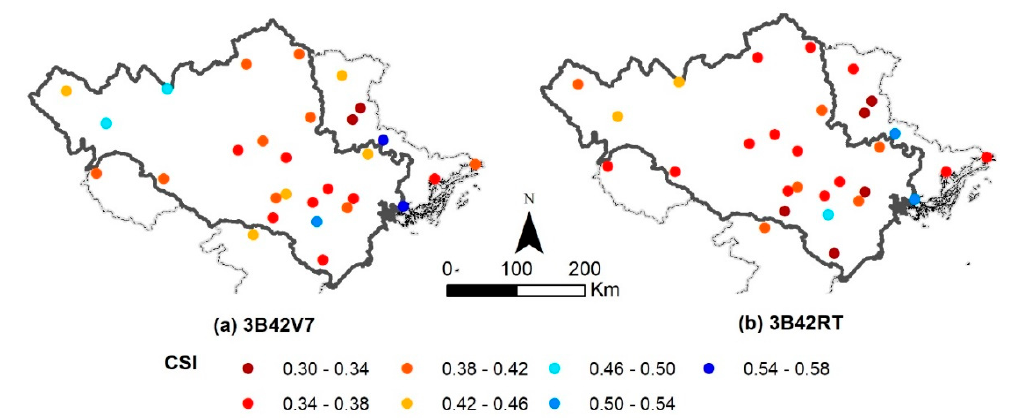
Figure 6. Critical success index (CSI) score’s spatial performance of TMPA rainfall data against observation data from March 2000 to December 2016 over the Red–Thai Binh River basin. The grey line is the Red–Thai Binh River Basin boundary within Vietnam territory.